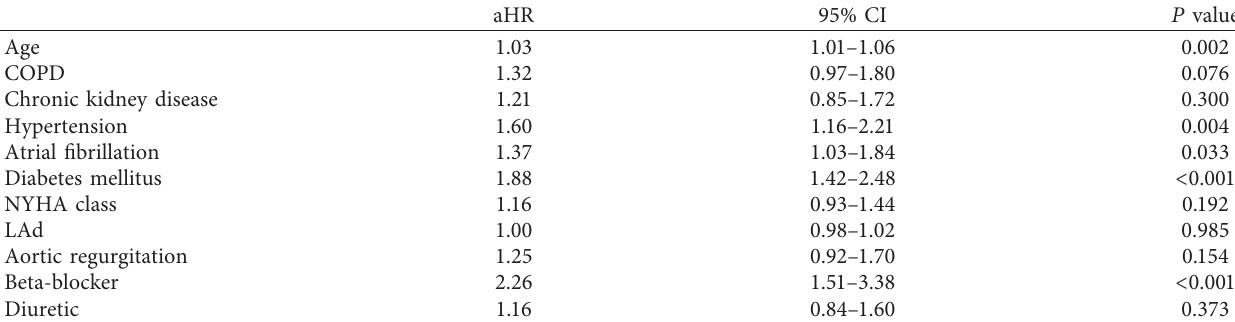
Table 3: Multivariable cox regression analysis for MACCEs in elderly VHD patients.